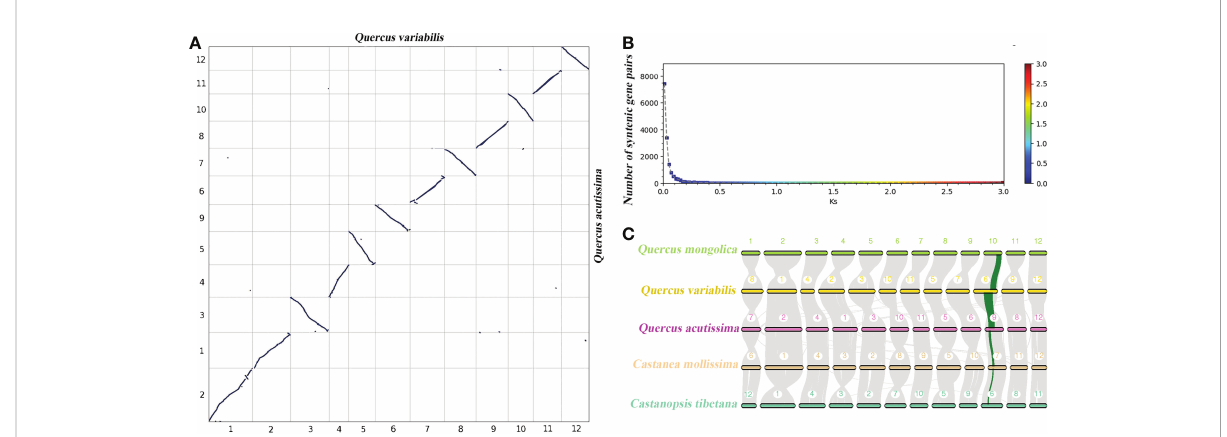
FIGURE 3 Syntenic dot plot and synteny analysis between Q. acutissima and other evaluated species. (A) Syntenic dot plot between the Q. acutissima and Q. variabilis genome. (B) Ks distribution between the Q. acutissima and Q. variabilis genome. (C) Synteny analyses among the genomes of Q. acutissima, Q. mongolica, Q. variabilis, C. mollissima and C. tibetana. Synteny blocks between paired chromosomes are connected by gray lines; one representative orthologous block (green lines) is